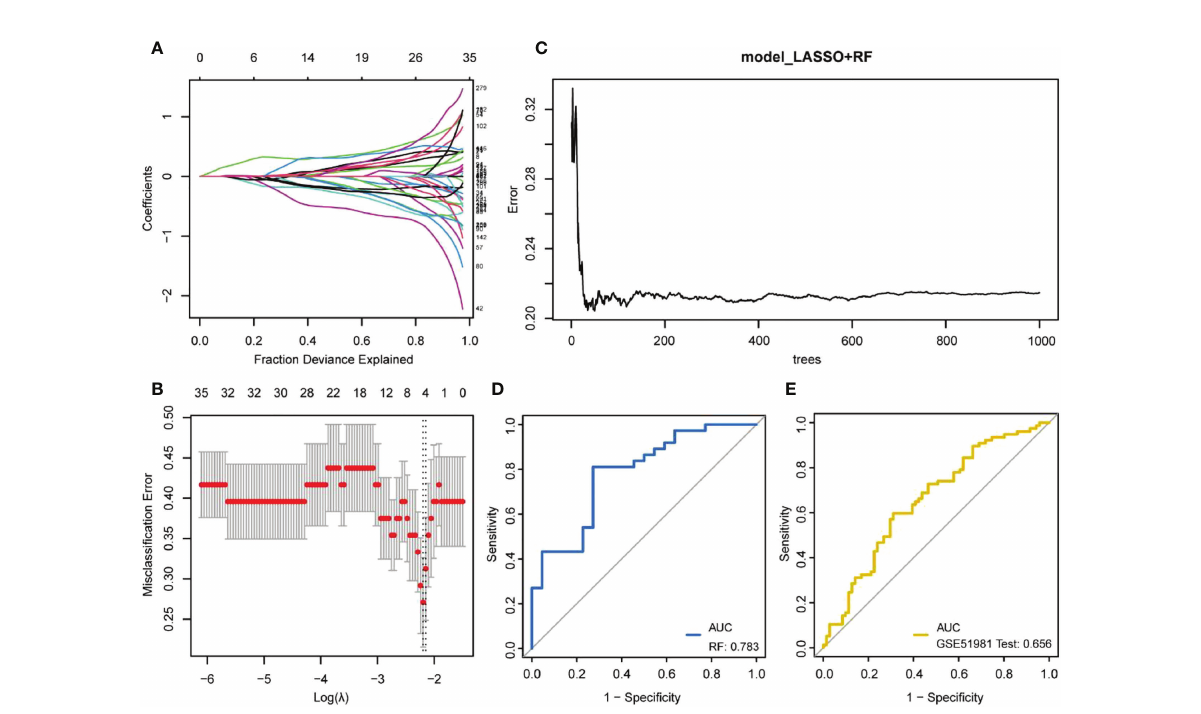
FIGURE 4 Machine learning model building. (A, B) LASSO regression model establishment. (A) the number and coef fi cients of selected features in different l states during the model establishment; (B) the best model (left dashed line) and the simplest model (right dashed line). The upper value represents the number of features included in the model for the l value; (C) The training process of random forests; (D) ROC curve veri fi ed by internal data sets; (E) ROC curve veri fi ed by external data